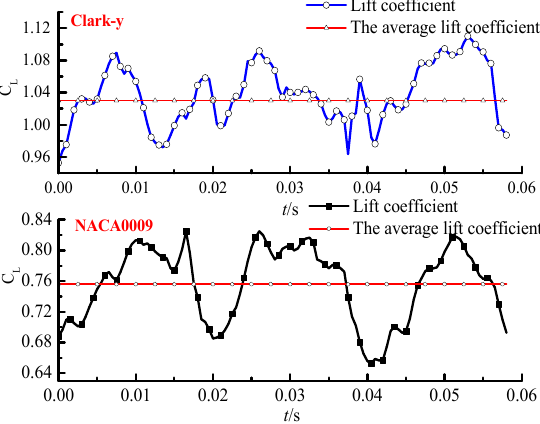
Figure 7. The time fluctuations of lift coefficients of the two hydrofoils.